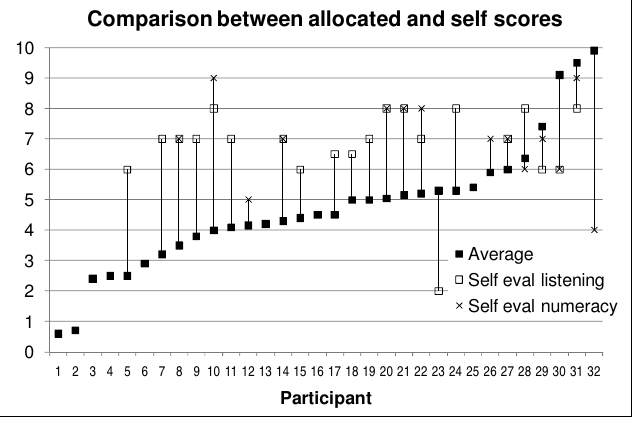
Fig. 4. Comparison of assignment scores with self-evaluation of competence.